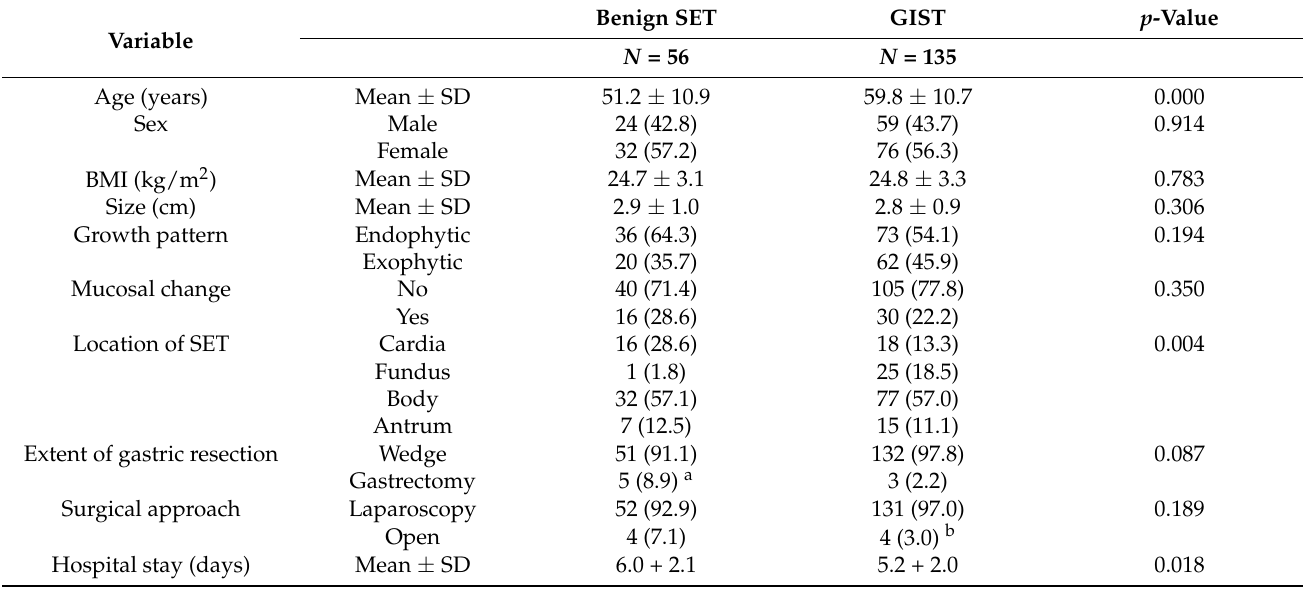
Table 2. Comparison of benign SETs and GISTs.